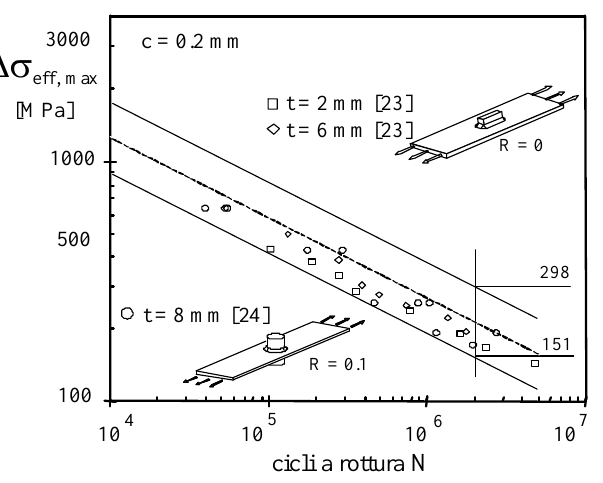
Figura 8: Previsione della vita a fatica di giunti irrigiditi utilizzando il metodo del gradiente implicito (t spessore piatto principale).